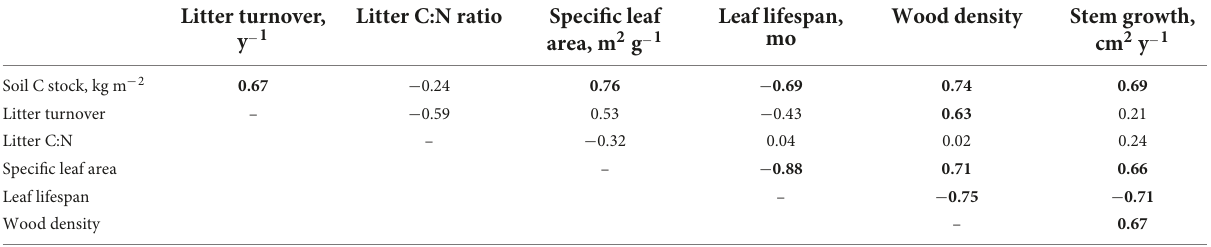
TABLE 3 Spearman’s correlations among species-specific soil C stocks, leaf functional traits, and litter characteristics across the 12 native tree species for which functional trait data were